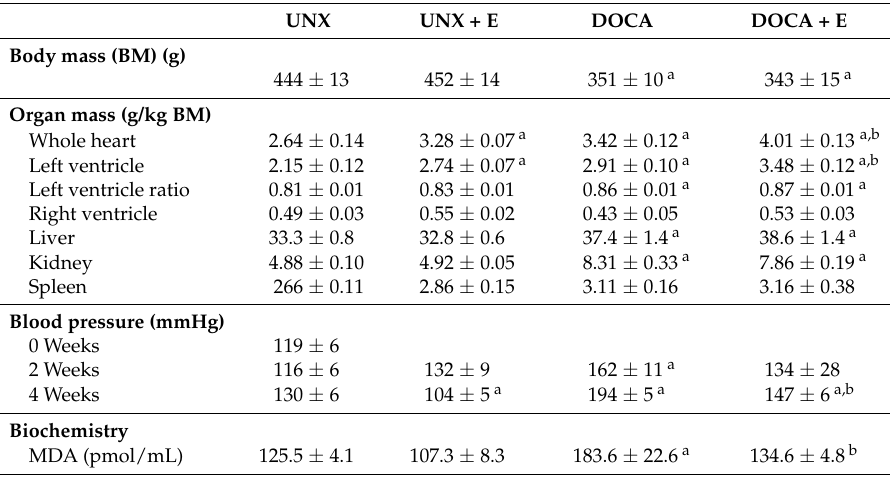
Table 1. Biometric and haemodynamic